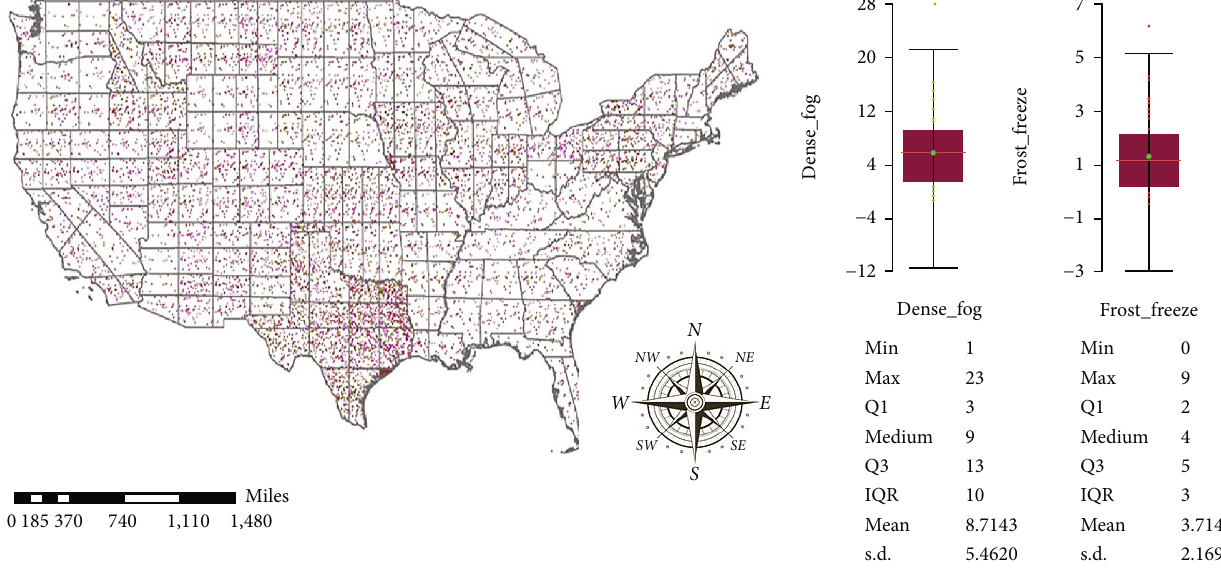
Figure 7: Dense fog and frost/freeze event correlation diagram. Table 4: Geographically weighted regression model test results. R 2 -2log-likelihood A